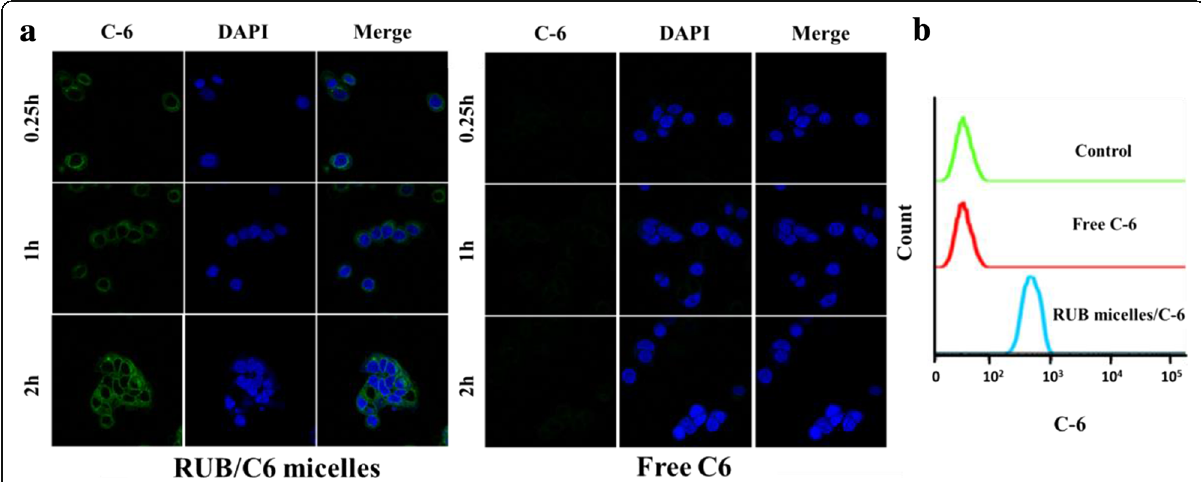
Fig. 5 In vitro uptake behavior of RUB-based micelles in breast cancer cell model MCF-7. a Fluorescence micrographs of MCF-7 cells were imaged after incubation with free C6 or RUB/C6 micelles for 2 h (excitation 488 nm, emission 500~530 nm). Scale bars 10 μ m. b Cell binding of indicated C6 formulations (4.5 mg/ml) on MCF-7 cells at 2 h was measured by flow cytometry (FACS)